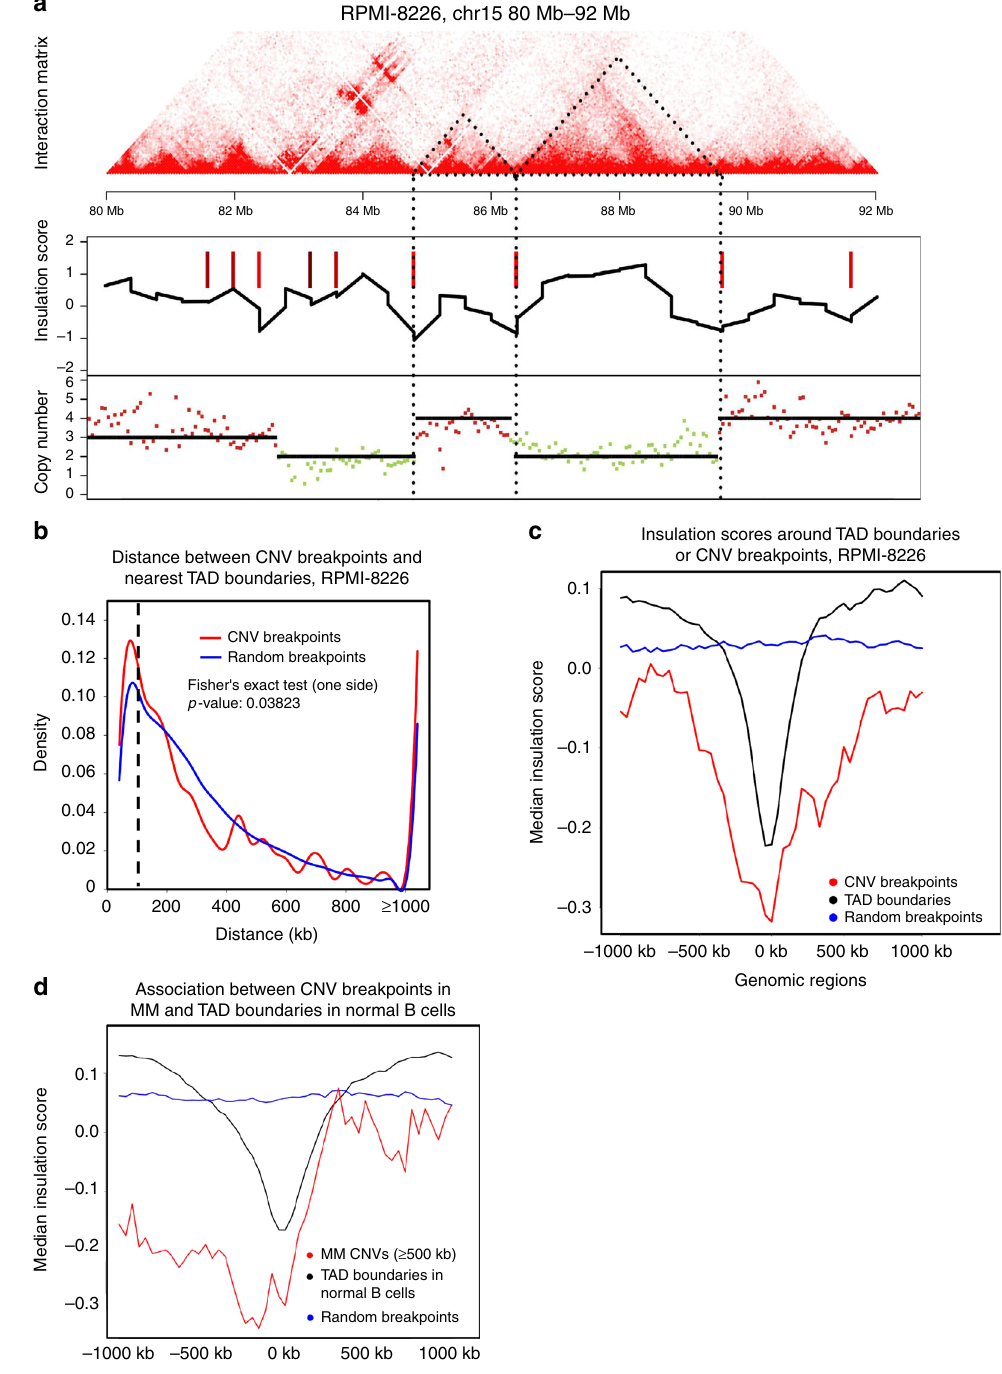
Fig. 3 CNV breakpoints associated with TAD boundaries. a Hi-C interaction matrix of a region (chr15: 80 Mb-92 Mb) in RPMI-8226 shows the association between TAD boundaries and CNV breakpoints. Top: Hi-C interaction matrix, middle: TAD boundaries (vertical bars) and insulations scores, bottom: copy number variations. The dashed triangles indicate two TADs coinciding with CNV blocks. b The distribution plots of the distance between all CNV breakpoints (red line) or random sites (blue line) to their nearest TAD boundaries in RPMI-8226 cells. c The averaged insulation scores at TAD boundaries (black line) or CNV breakpoints (red line) in RPMI-8226 are lower compared to surrounding regions, in contrast to random sites (blue line). d The averaged insulation scores around different sets of genomic locations in B cells (GM12878). Blue line: randomly selected sites; black line: TAD boundaries in GM12878; red line: CNV breakpoints from the CNVD